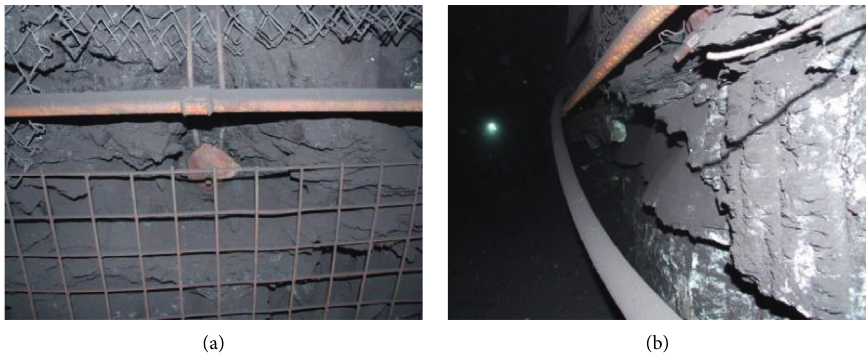
Figure 17: Deformation and failure of roadway in Shitanjing No. 2 mine. (a) 24 ° . (b) 27 °